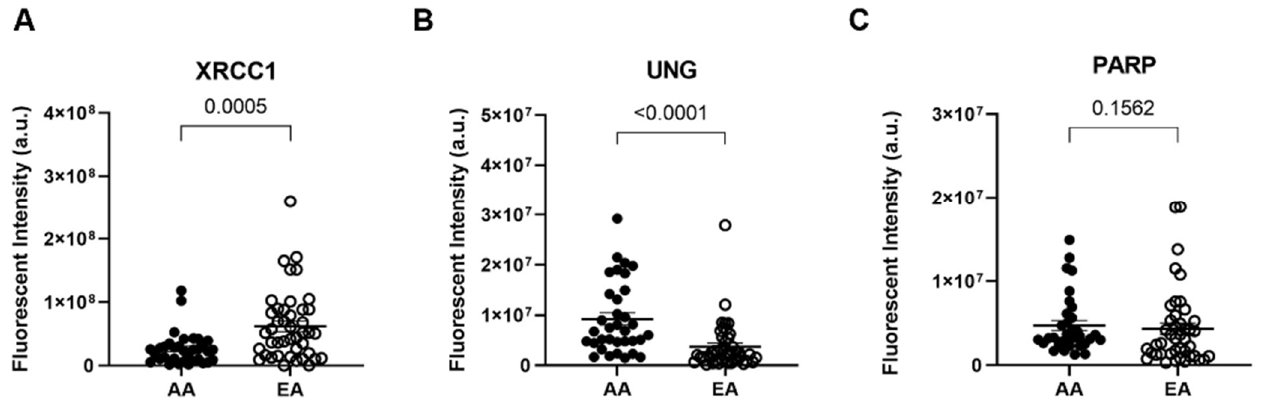
Figure 3. African American prostate tumors exhibit lower XRCC1 expression and higher UNG expression than European American tumors, impairing base excision repair of uracil and pyrimidine damage. Quantitative graphs measuring immunofluorescence for ( A ) XRCC1, ( B ) UNG, and ( C ) PARP1 in AA and EA PCa patients ( n = 34 AA and 43 EA PCa patients). Data represented as the mean ± the standard error of the mean. The Mann–Whitney test was used to calculate statistical significance. Images for each patient are provided in Supplemental Figure S1.